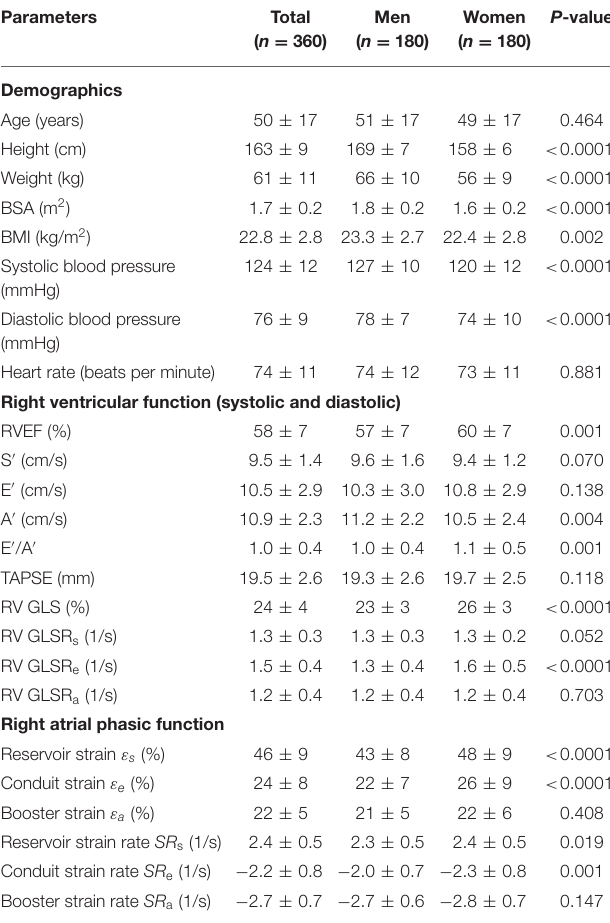
Dataarepresentedasmean ± SD.P-valueisfort-testbetweensexes.BSA,bodysurface area; BMI, body mass index; RV, right ventricular; EF, ejection fraction; S ′ , peak systolic tricuspid annular velocity; E ′ , peak early diastolic tricuspid annular velocity; A ′ , peak late diastolictricuspidannularvelocity;TAPSE,tricuspidannularplanesystolicexcursion;GLS, globallongitudinalstrain;GLSR s ,peaksystolicgloballongitudinalstrainrate;GLSR e ,peak early diastolic global longitudinal strain rate; GLSR a , peak late diastolic global longitudinal strain